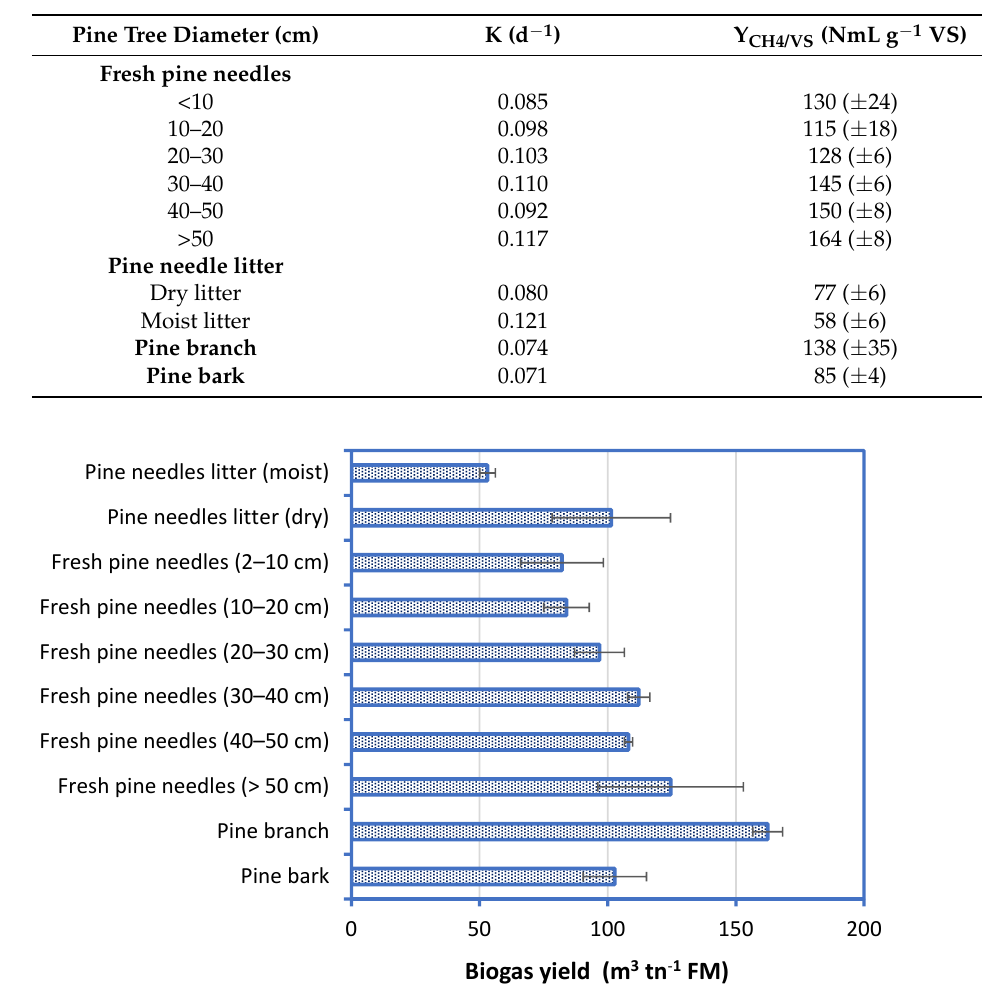
Figure 5. Summary of biogas yield values per tn fresh matter (FM) for different pinus forest biomass samples.